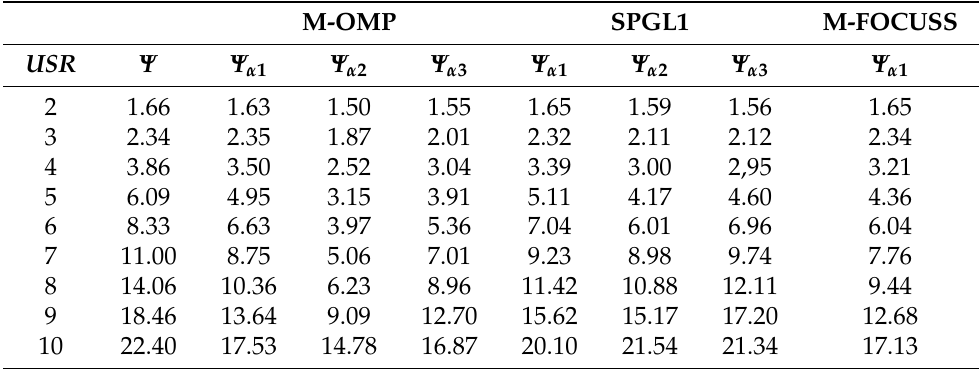
Table 9. Comparison of PRD values from the algorithms using the three dictionary matrices at several USR values, for ECG signal No. 106.